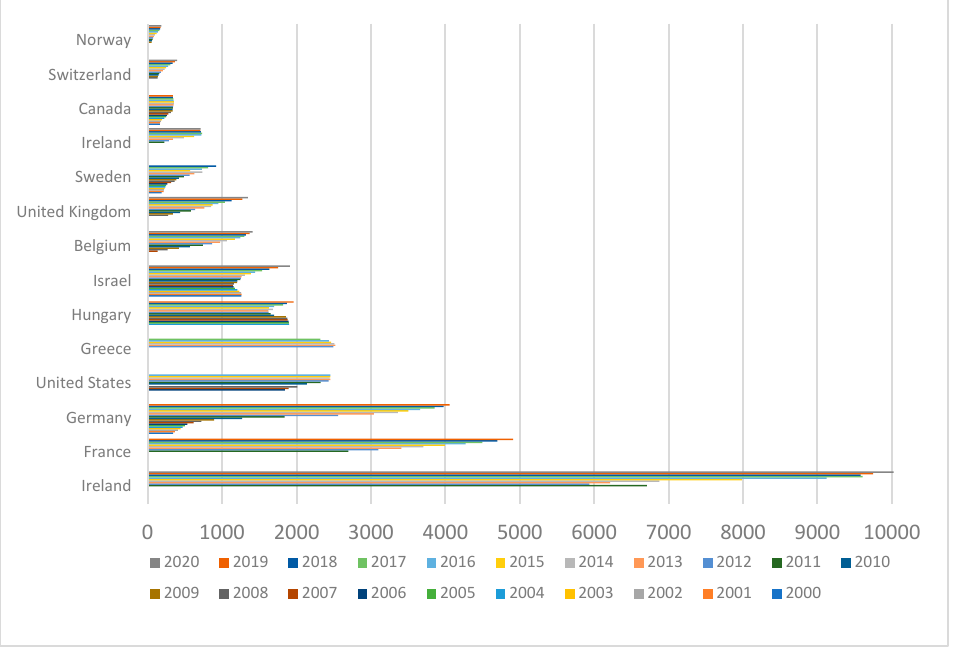
Figure 8. Stock of Romanian doctors in OECD countries, selected countries with more than 100 employed doctors, in the period 2000–2020.